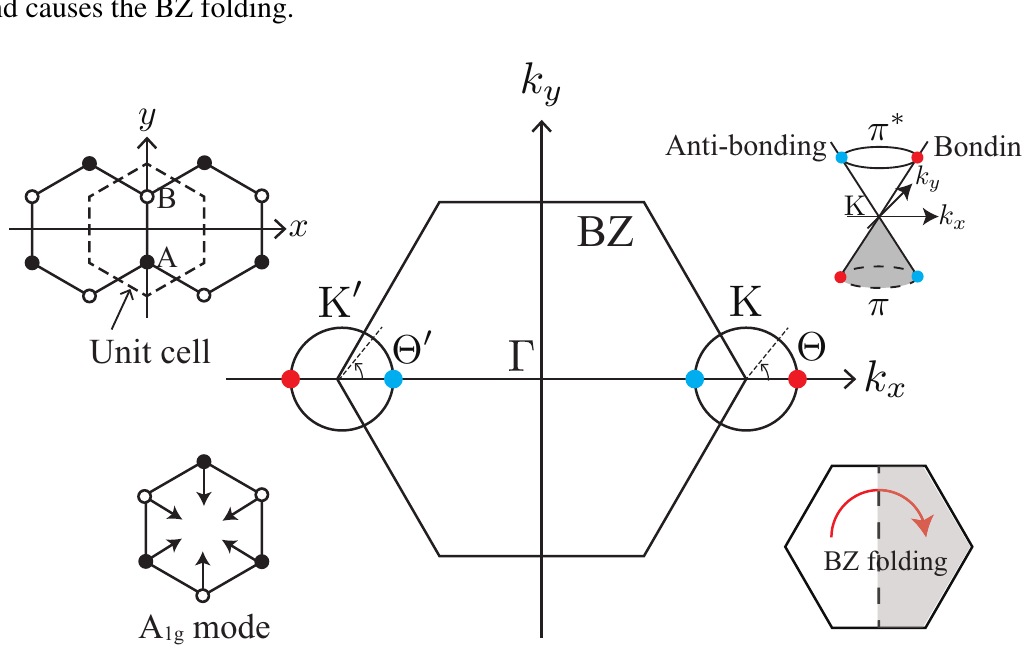
= (4 π/ 3 a, 0) ( − k ), F F modes that consist only of C-C bond 1 g , k ) with a state at ( − k , k ) , x y x y